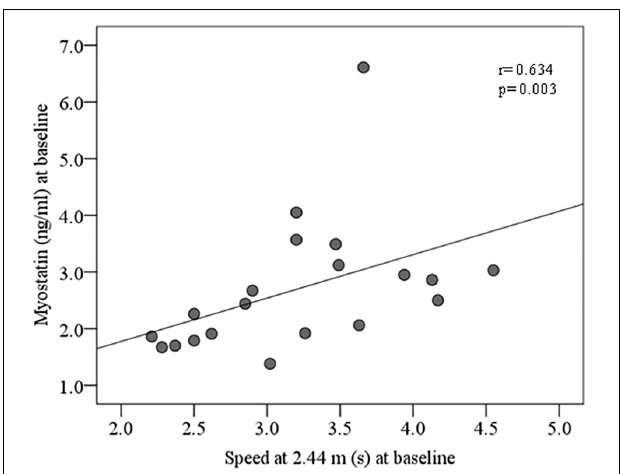
FIGURE 2 | Bivariate correlation between circulating myostatin and speed at 2.44 m at baseline in control